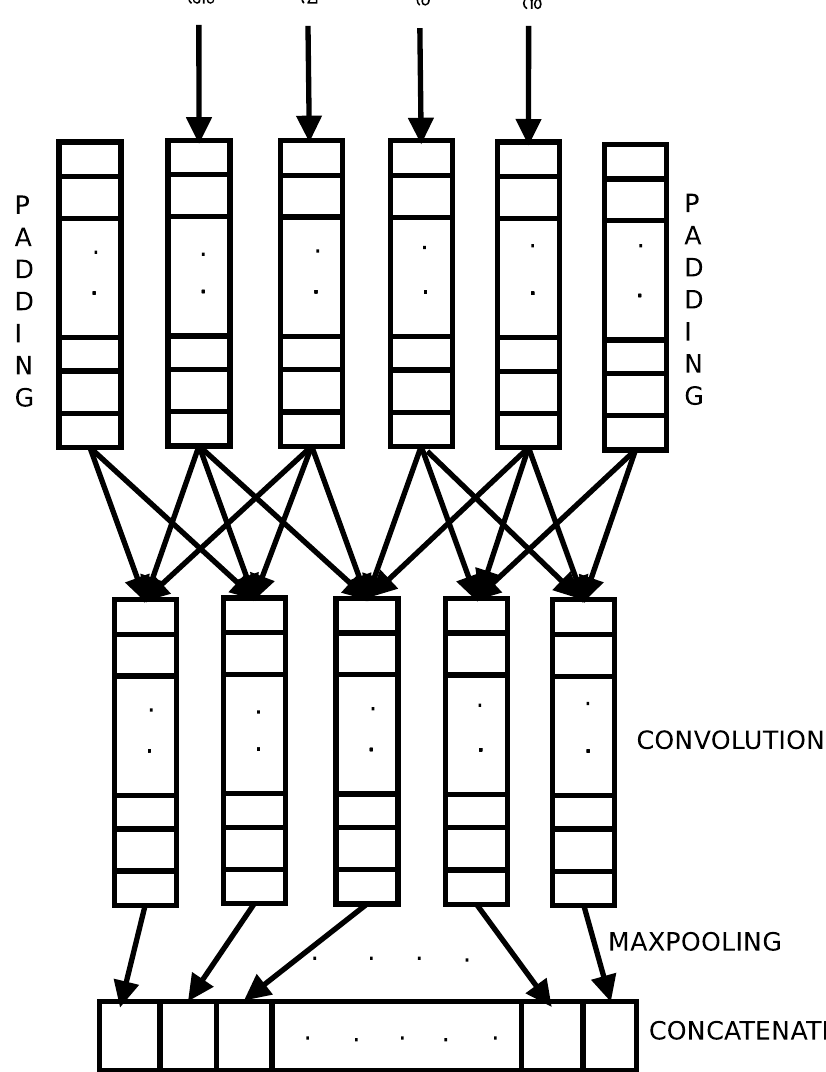
Figure 3. Architecture of the character-based word composition